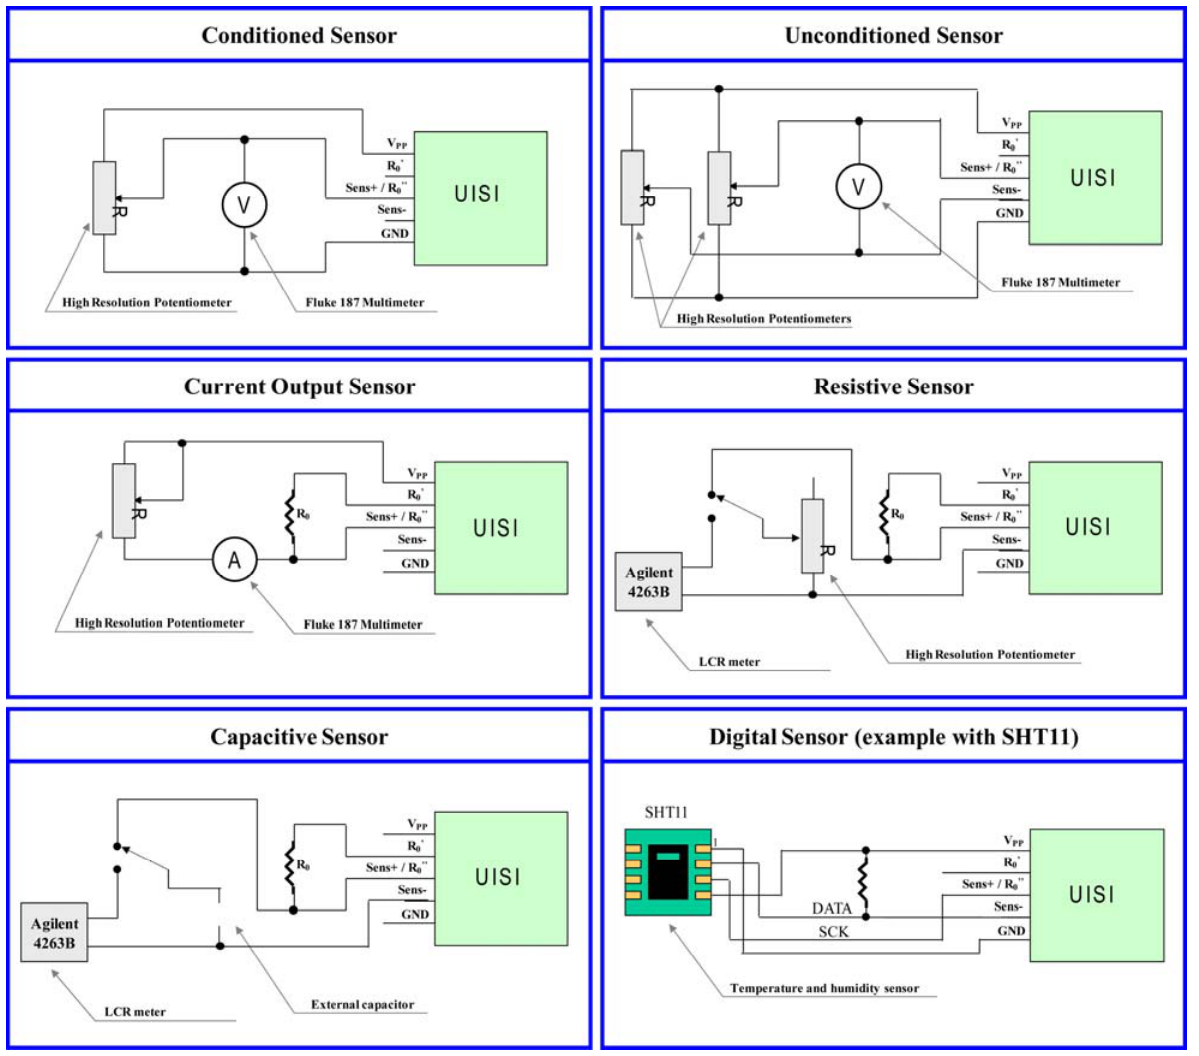
Figure 14. Configuration setups for the proposed sensor configuration front